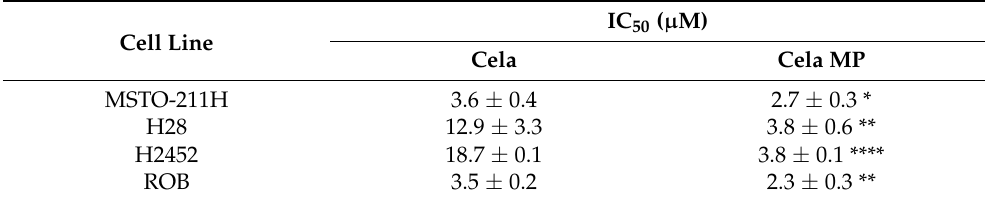
Figure 4. Cytotoxicity of Cela and Cela MPs against ( A ). MSTO-211H, ( B ). H28, ( C ). H2452, and ( D ). ROB cell lines. Cells were treated with different concentrations of each treatment for 48 h and cell viability was measured using MTT assay. Cells grown in media were considered as control (100%). Data represent mean ± SD of three separate trials, each with n = 6. Table 2. Quantification and comparison of IC 50 values derived from cytotoxicity studies. Data represent mean ± SD of three independent trials of n = 6 for each trial. Significance between groups was analyzed by an unpaired t -test. * p < 0.05, ** p < 0.01, **** p < 0.0001.